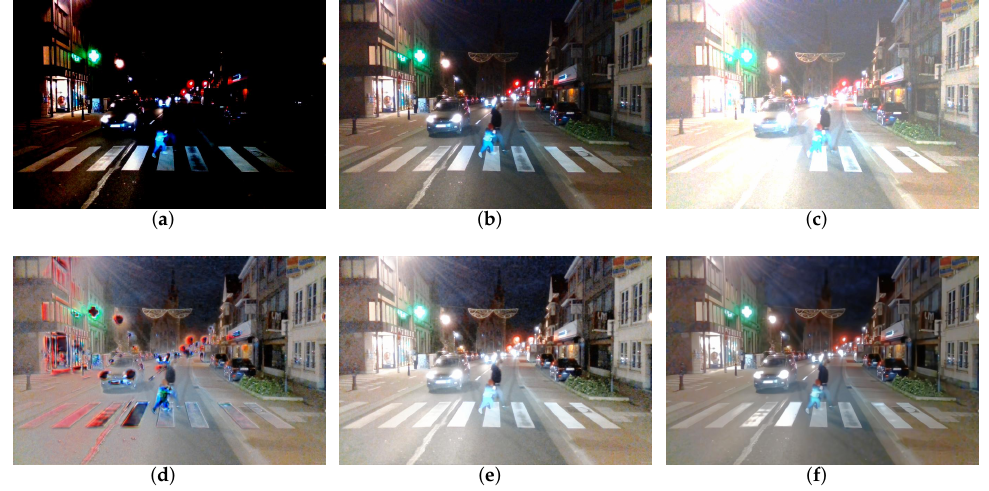
Figure 8. Image fusion for traffic scene. ( a ) Under-exposure image. ( b ) Middle-exposure image. ( c ) Over-exposure image. ( d ) Fusion by AHDRNet [16]. ( e ) Fusion by our basic network. ( f ) Fusion by fine-tuned network.